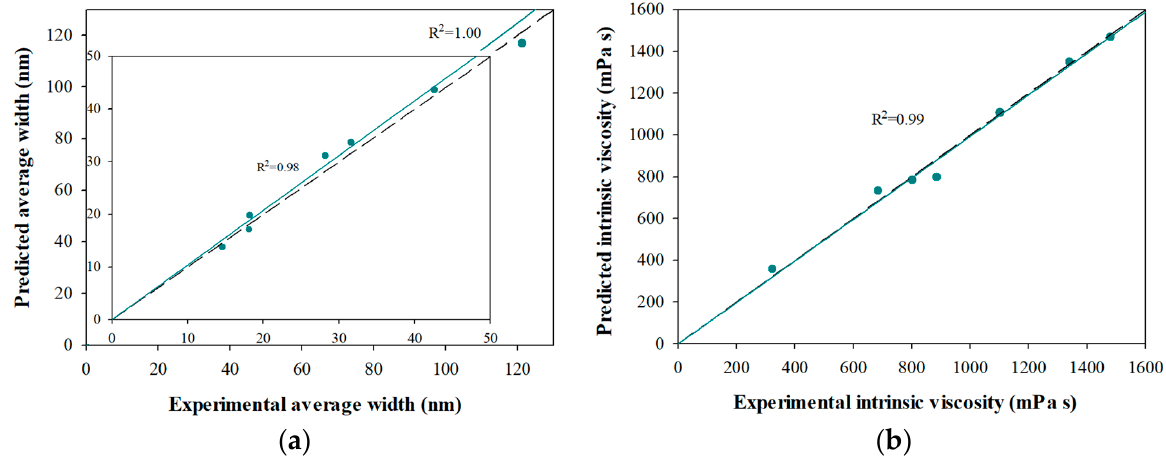
Figure 2. ( a ) Pareto chart for average width and ( b ) intrinsic viscosity by fractions in